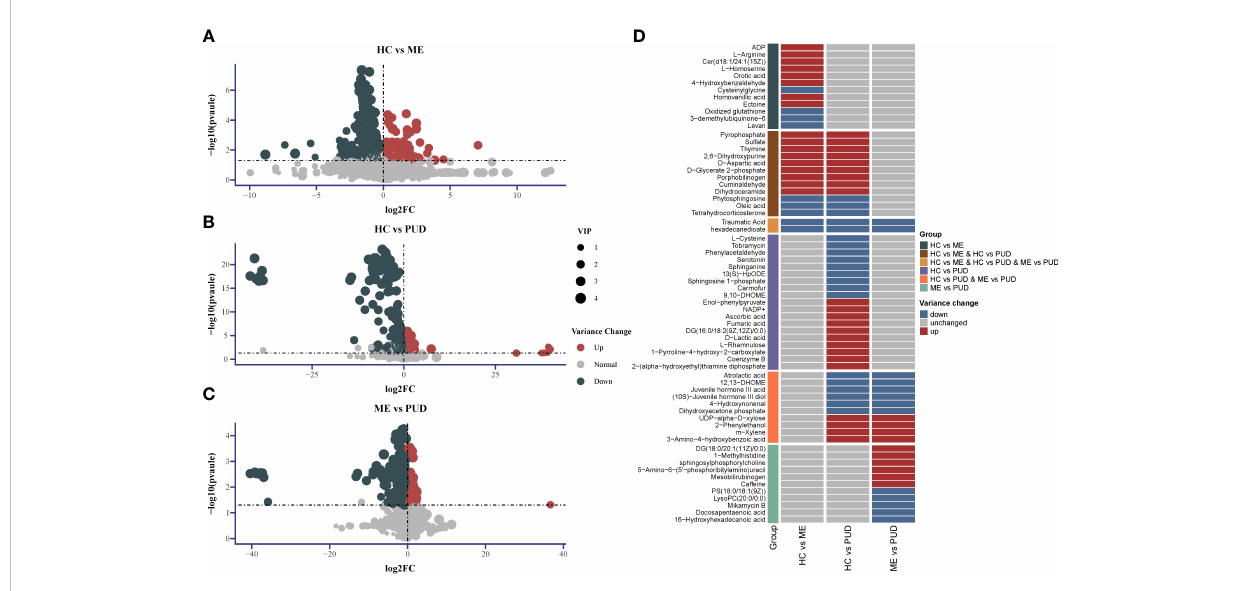
FIGURE 6 Differential metabolite Volcano and Heatmap. (A) , the distribution of differential metabolites for HC vs. ME; (B) , the distribution of differential metabolites for HC vs. PUD; (C) , the distribution of differential metabolites for ME vs. PUD; (A-C) indicates the up-regulated and down-regulated distribution of metabolites for each group of annotations; (D) indicates the distribution of the 66 differential metabolites in each group identi fi ed based on the KEGG database. 2-Hexaprenyl-3-methyl-5-hydroxy-6-methoxy-1,4-benzoquinone is equivalent to